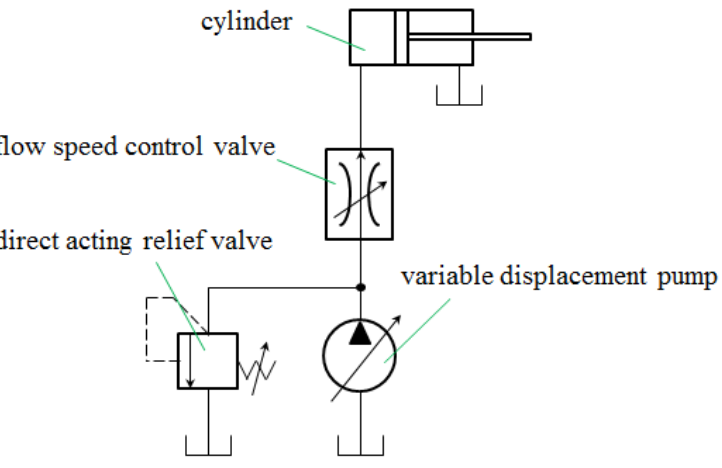
Figure 3. The volumetric throttling speed-control circuit with variable displacement pump.